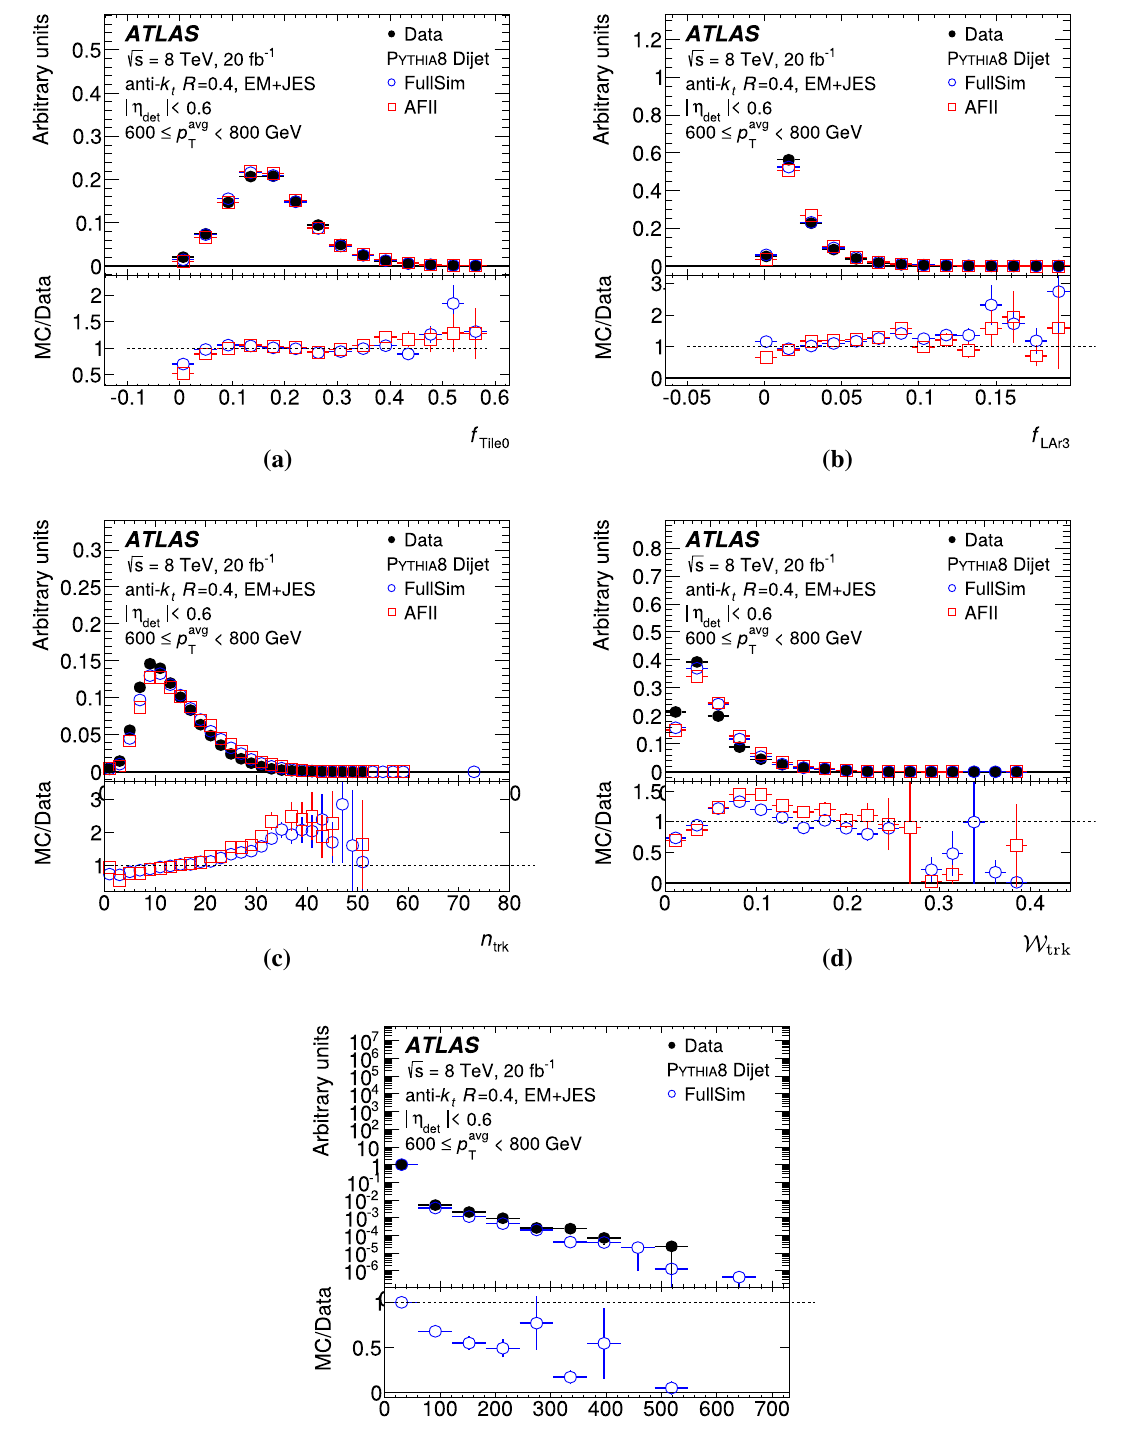
Fig. 7 Normalized distributions of f Tile0 , f LAr3 , n trk , W trk and N segments for jets | η det | < 0 . 6 in dijet events with 600GeV < p avg 800GeV in the data (filled circles) and Pythia8 MC simulation with both full (empty circles) and fast (empty squares) simulation. All jets